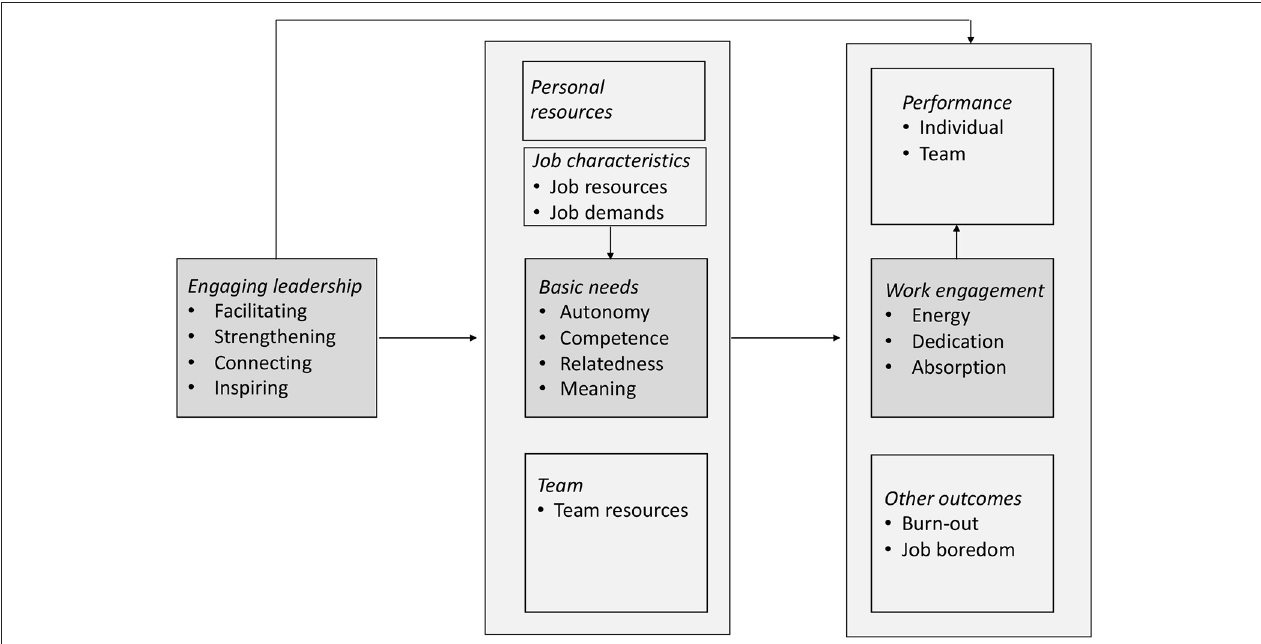
FIGURE 1 | Engaging leadership in the work